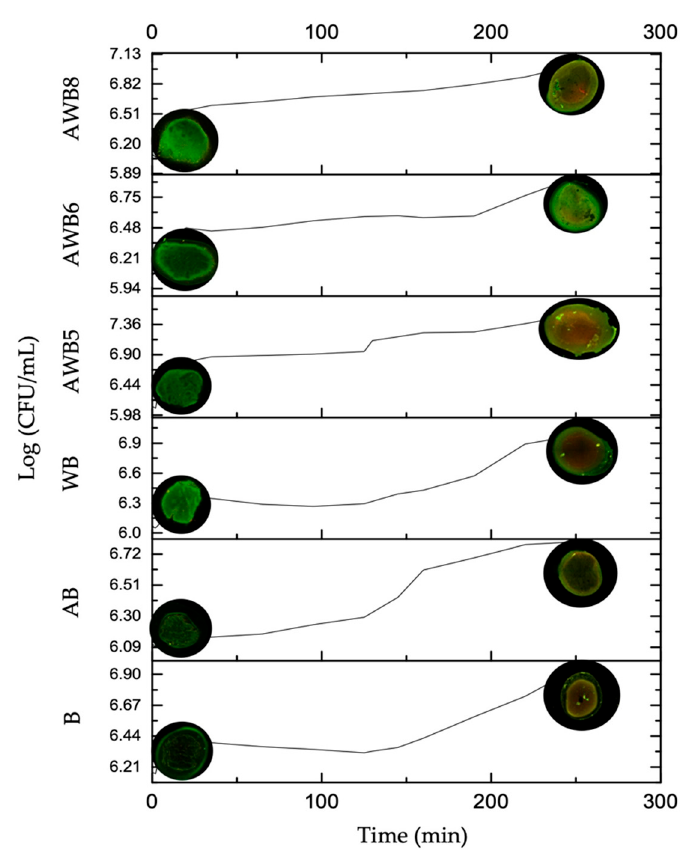
Figure 6. Cell release of S. boulardii beads (Log CFU/mL) under in vitro gastrointestinal digestion conditions.